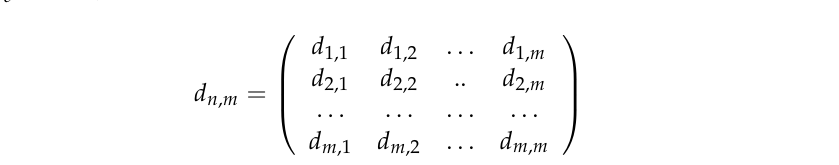
Figure 3. Schematic diagram of phenology time-weighted dynamic time warping (PT-DTW). For the specific calculation process of PT-DTW, it is assumed that there are two curves, Q = ( q 1 , q 2 , q 3 , . . . , q m ), R = ( r 1 , r 2 , r 3 , . . . , r m ), with the same number of nodes in the event sequence. Q and R are the curves of target event sequence and reference time series, (cid:12) (cid:12) respectively. For each element in the matrix (6): d = (cid:12) q i − R j (cid:12) + M i , j , i ∈ [ 1, m ] , j ∈ [ 1, m ] , M i , j